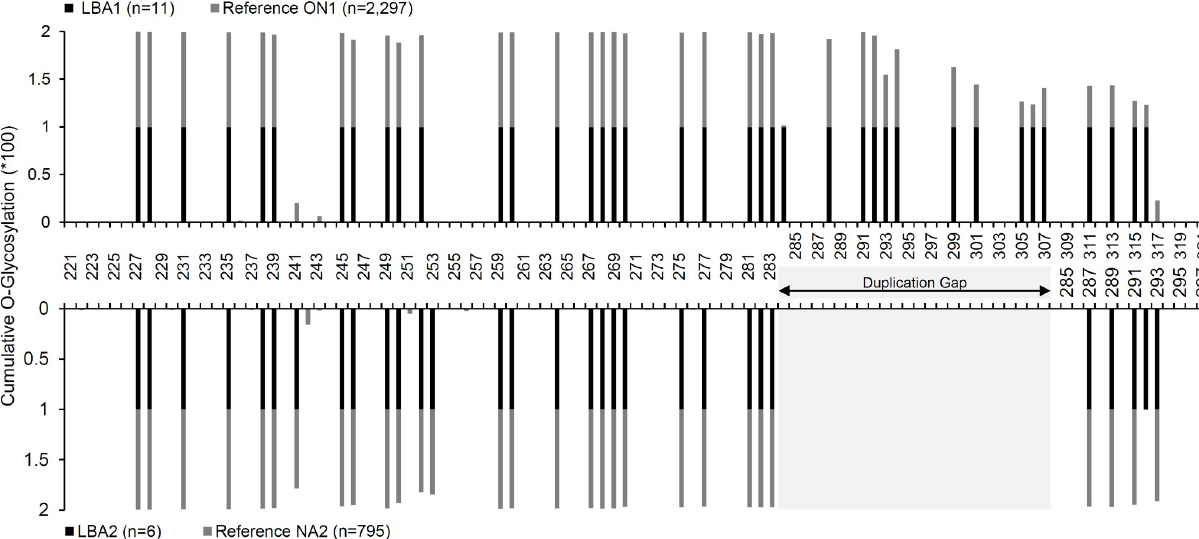
Fig 5. Glycosylation profiles of the Lebanese LBA1 and LBA2 specimens shown as cumulative proportion of glycosylated residues per RSV-A genotype. Highlighted region represents the duplication